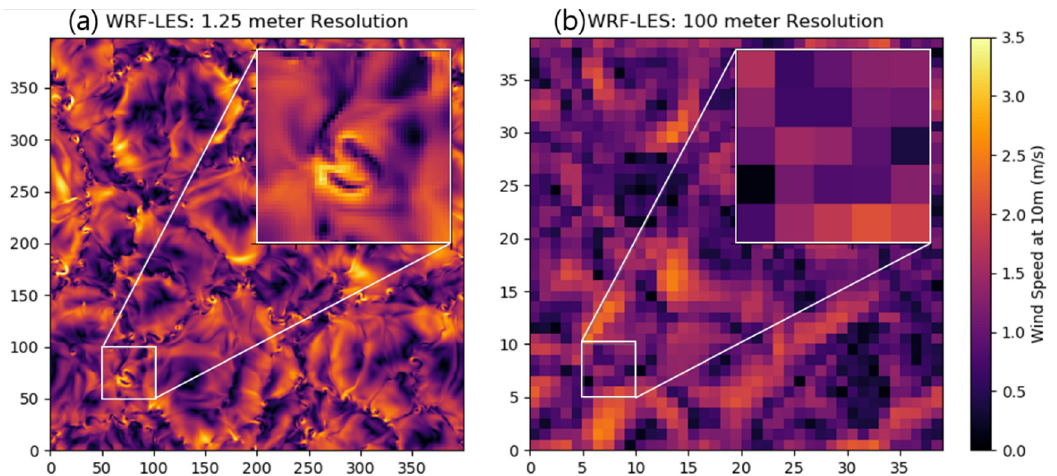
Figure 1. WRF-LES result: wind speed at 10 m. ( a ) dx = dy = 1.25 m (3200 × 3200 resolution), dt = 0.01 s. ( b ) dx = dy = 100 m (40 × 40 resolution), dt = 1 s.